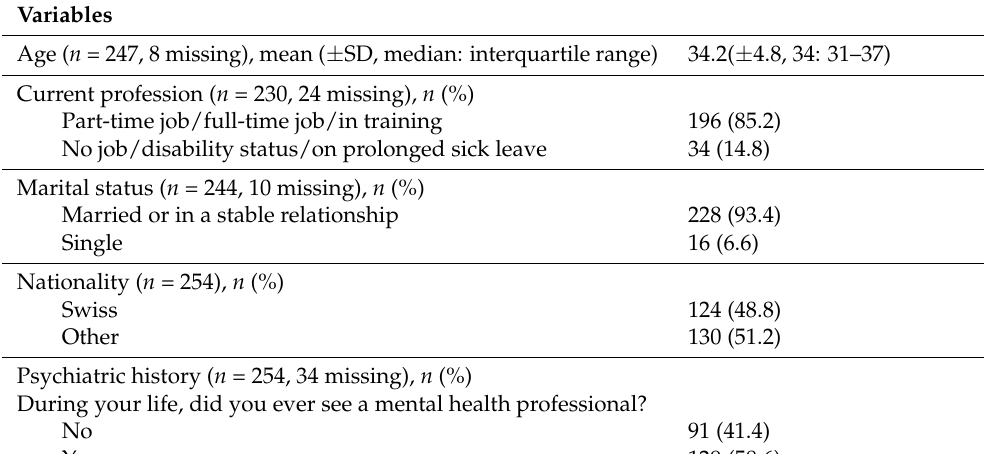
Table 1. Socio-demographic data and psychiatric and traumatic event history ( n =